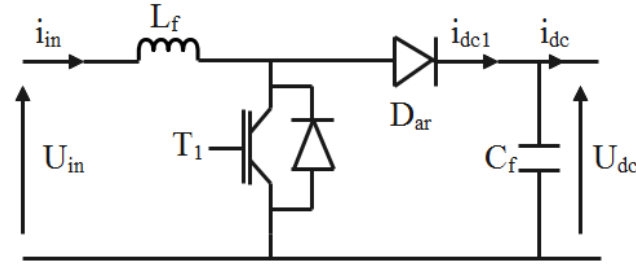
Figure 4. Unidirectional boost chopper.